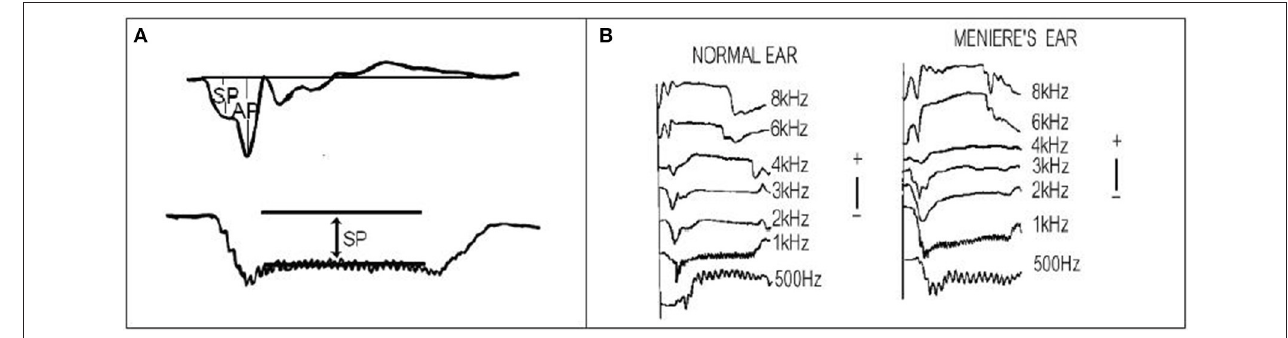
FIGURE 5 | (A) Measurement of the click SP/AP ratio. (B) Tone burst recordings from a normal ear and an ear affected by Meniere’s Disease.